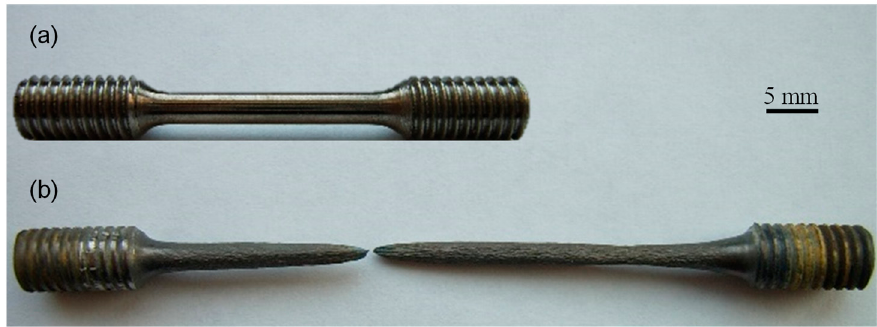
Figure 6. The 2Zr-1.2O alloy specimen before ( a ) and after ( b ) tensile test at 750 °C.